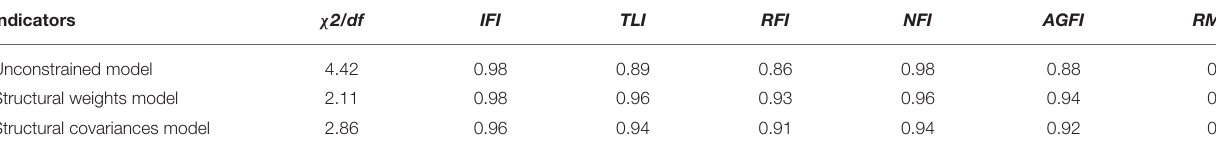
TABLE 6 | Fit index of the gender group analysis model